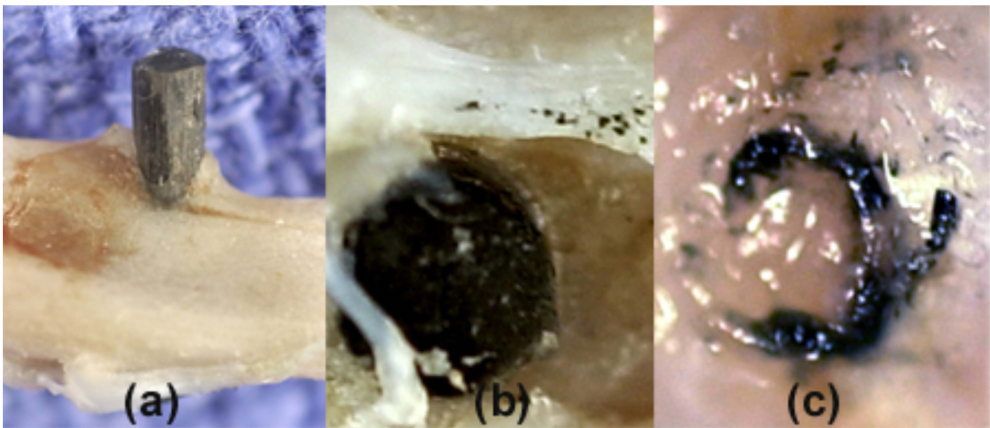
Figure 2. Photographs ( a ) epoxy/carbon-fiber-reinforced composite extends above tibial cortical bone with bone enhanced to grow upward on the side of the exposed carbon-fiber implant; ( b ) implant extending above cortical bone shows excess osteoid production apparently encouraged from small carbon fiber fragments; ( c ) soft tissue covering the cortical bone formed a toughened seal on the end of the implant associated with the carbon fiber fragments.